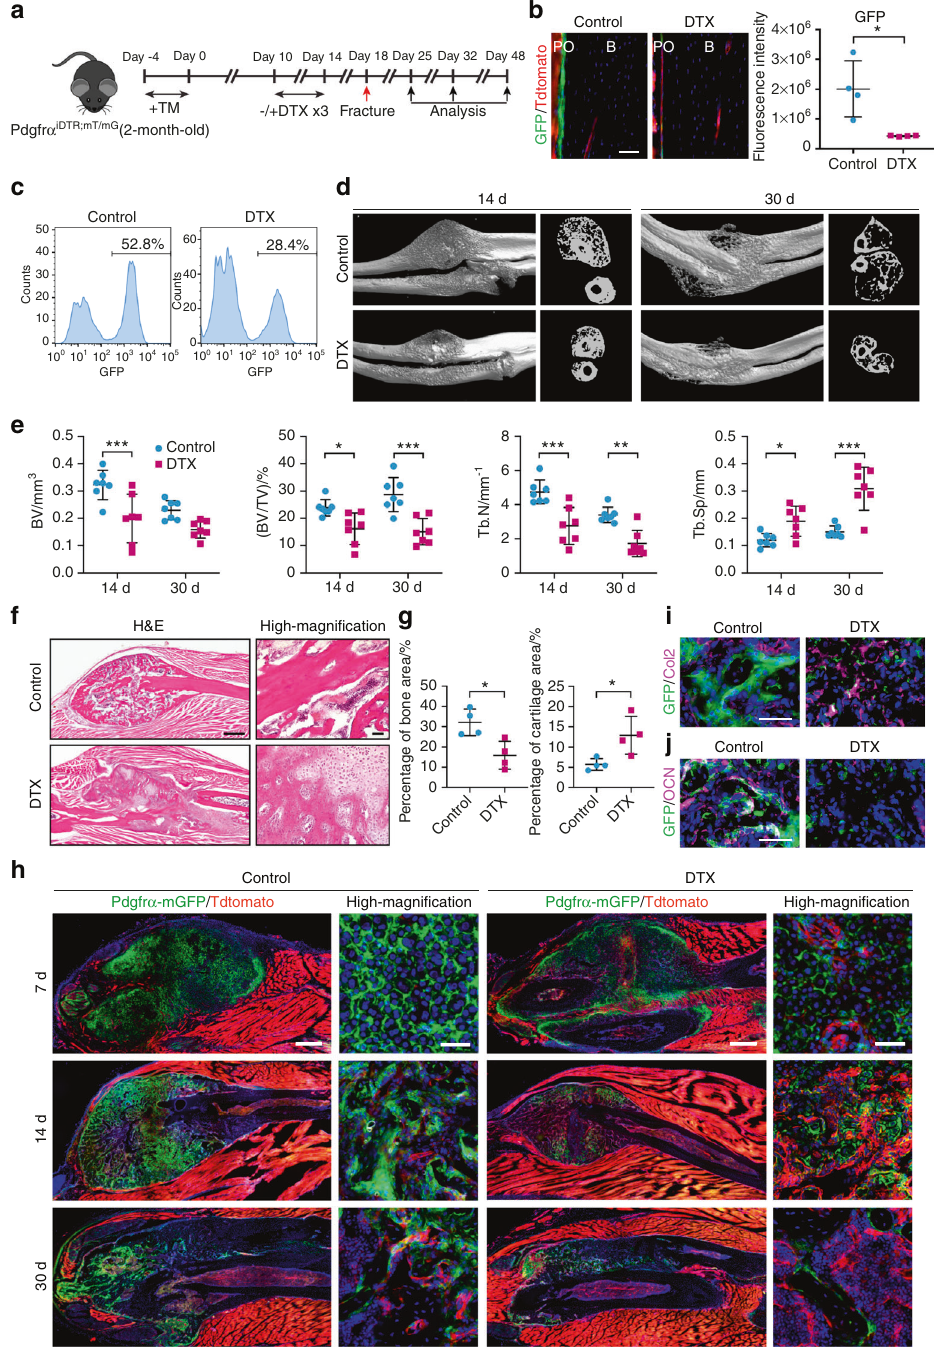
Fig. 4 The depletion of periosteal PDGFR α reporter + progenitor cells impairs fracture repair. a PDGFR α iDTR;mT/mG animals were injected with TM and DTX, and forelimb fractures were then performed. The analysis was performed 7, 14, and 30 d after fracture. b Ef fi ciency of cell depletion in the periosteum, as shown by representative images and histologic quanti fi cation of PDGFR α reporter activity (GFP) 14 d after DTX injection. Nuclei, DAPI (4 ′ ,6-diamidino-2-phenylindole, blue). c Ef fi ciency of PDGFR α reporter + cell depletion determined by fl ow cytometry 14 d after DTX injection. d Representative micro-CT 3D reconstructions and axial cross-sectional images obtained 14 and 30 d after fracture. e Quantitative analysis of micro-CT images obtained at 14 and 30 d after fracture. The analysis included the bone volume (BV), fractional bone volume (BV/TV), trabecular number (Tb.N), and trabecular spacing (Tb.Sp). f Representative H&E-stained images of the fractured callus in PDGFR α iDTR;mT/mG animals 14 d after fracture. g Percentages of bone and cartilage within the total callus area 14 d after fracture. h Representative tile scans and high-magni fi cation images of the fracture site and associated callus in PDGFR α iDTR;mT/mG reporter animals at 7, 14 and 30 d after fracture. Immunohistochemical staining of PDGFR α iDTR;mT/mG fractured calluses with or without DTX 14 d after injury, including ( i ) collagen type 2 (Col2) and ( j ) osteocalcin (OCN). Positive immunohistochemistry is shown in purple, and PDGFR α reporter activity (GFP) appears green. Scale bars: 500 μ m ( f , h (tile scan)) and 50 μ m ( b , f , h – j ). B bone, PO periosteum. The dot plots represent an individual animal, and the whisker plots indicate the mean and one-SD values. n = 4 animals per group ( b , c , f – j ) and N = 7 animals per group ( d , e ). * P < 0.05, ** P < 0.01, and *** P < 0.001, as assessed by two-tailed Student ’ s t